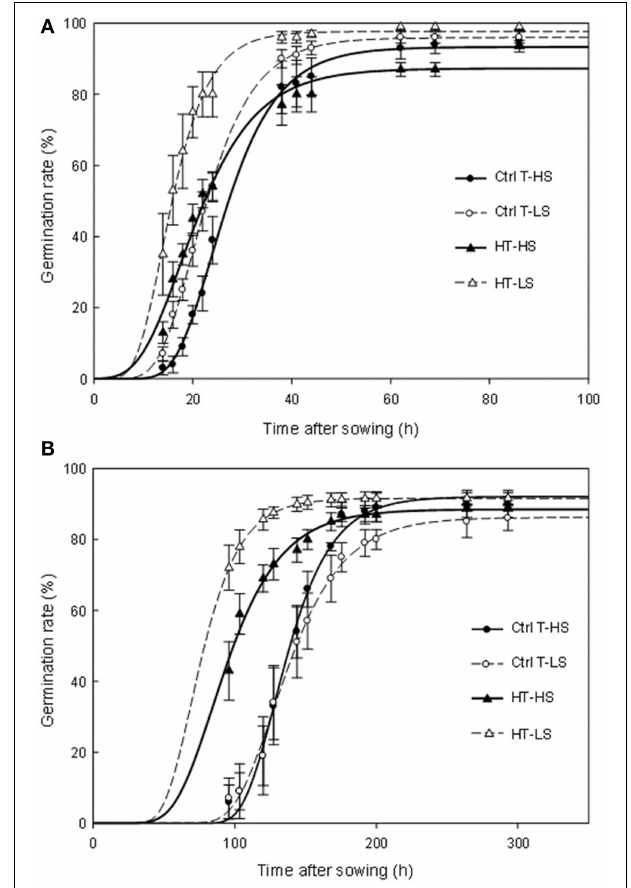
FIGURE 2 | Germination time courses at 20 ◦ C (A) and 5 ◦ C (B). Ctrl-T, Control temperature; HT, High temperature; HS, High sulfur; LS, Low sulfur. Vertical bars denote standard errors. Lines are fittings to a Gompertz function. F -values of the germination time courses and final germination percentages are given in Supplemental